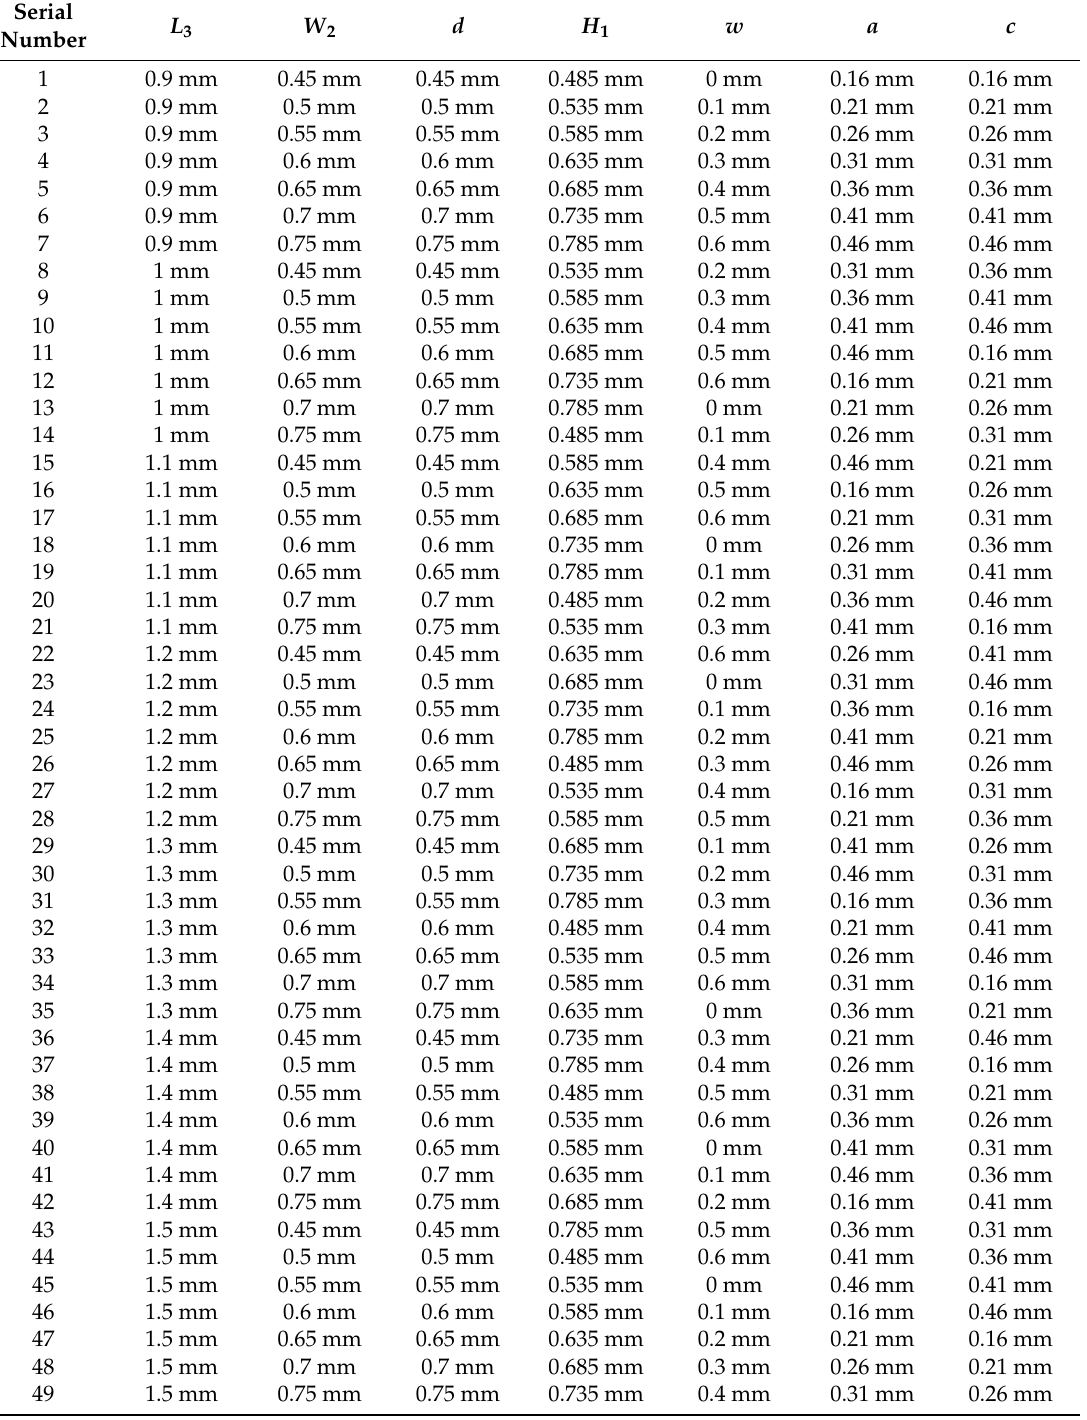
Table A3. Six-factor seven-level orthogonal